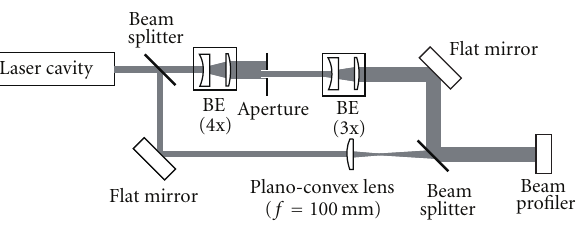
Figure 6: Optical schematic of the Mach-Zehnder interferometer. center position, and the beam radius were determined.